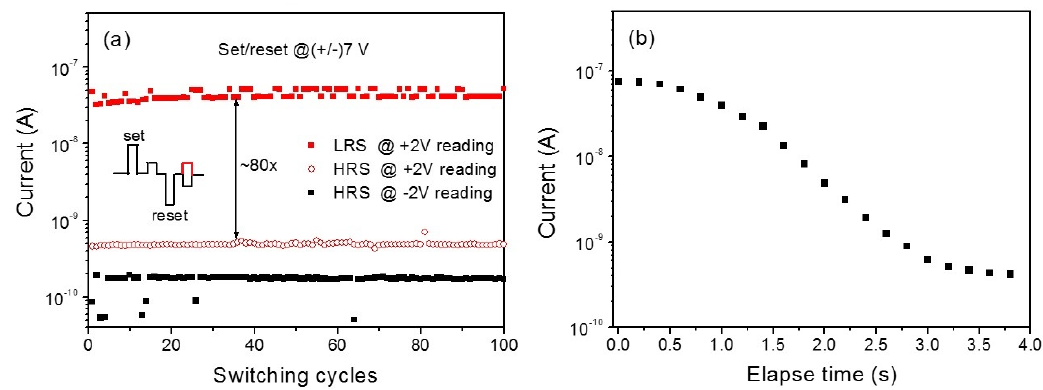
Figure 8. ( a ) Endurance performance of the memristive device based on g -Al:MgZnO/ZnO heterostructure film. ( b ) Retention characteristic of the device showing a short-term memory